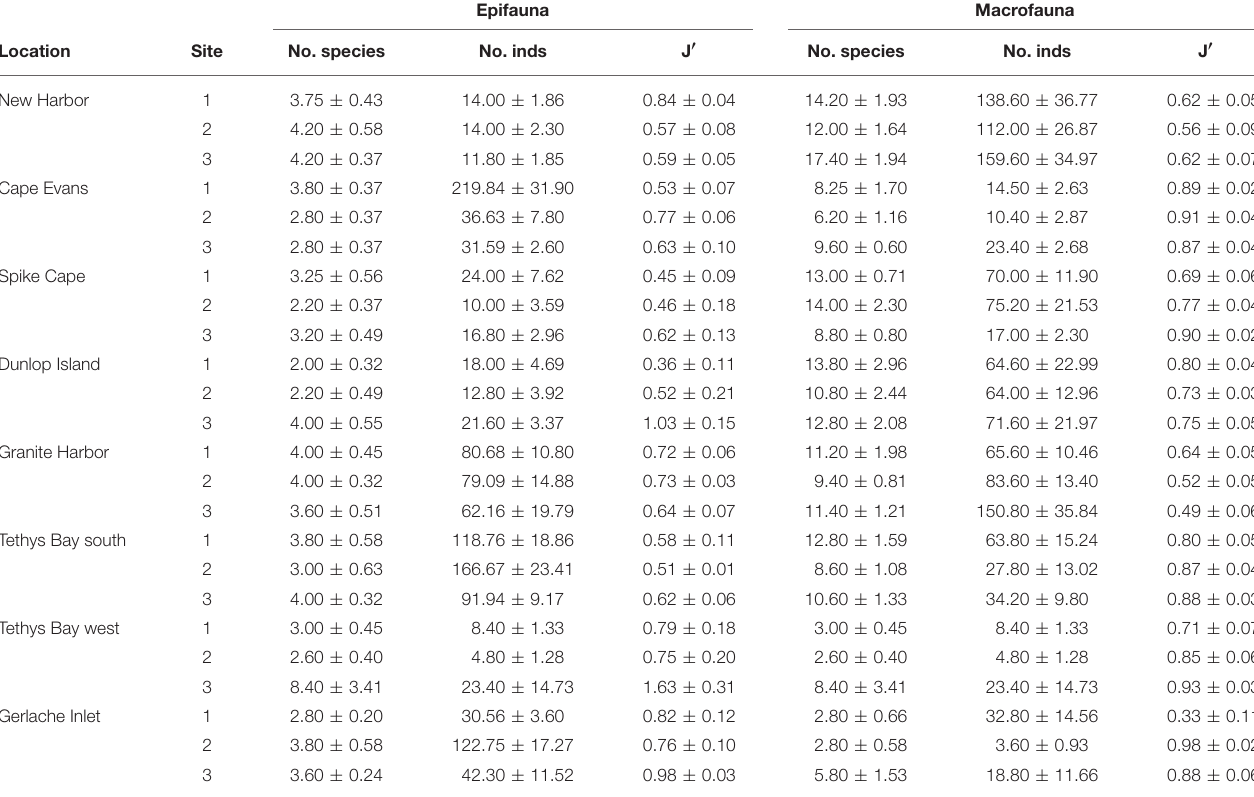
TABLE 3 | Summary diversity indices at each site and location for the epifauna determined using video, and the macrofauna determined using